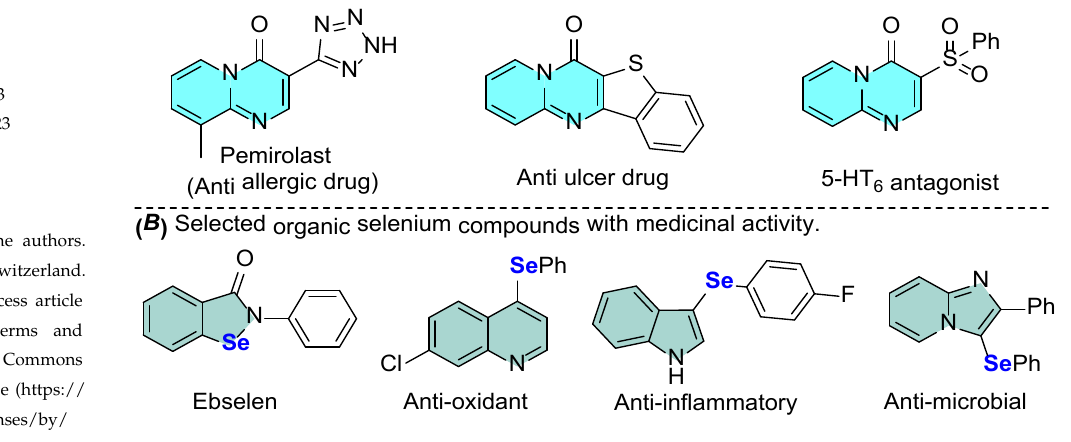
Figure 1. Representative biological skeletons.